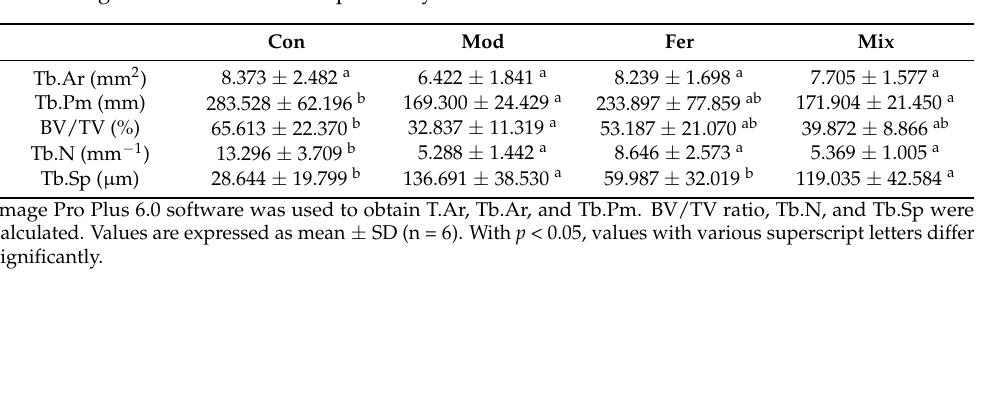
Table 1. Right tibial bone histomorphometry.